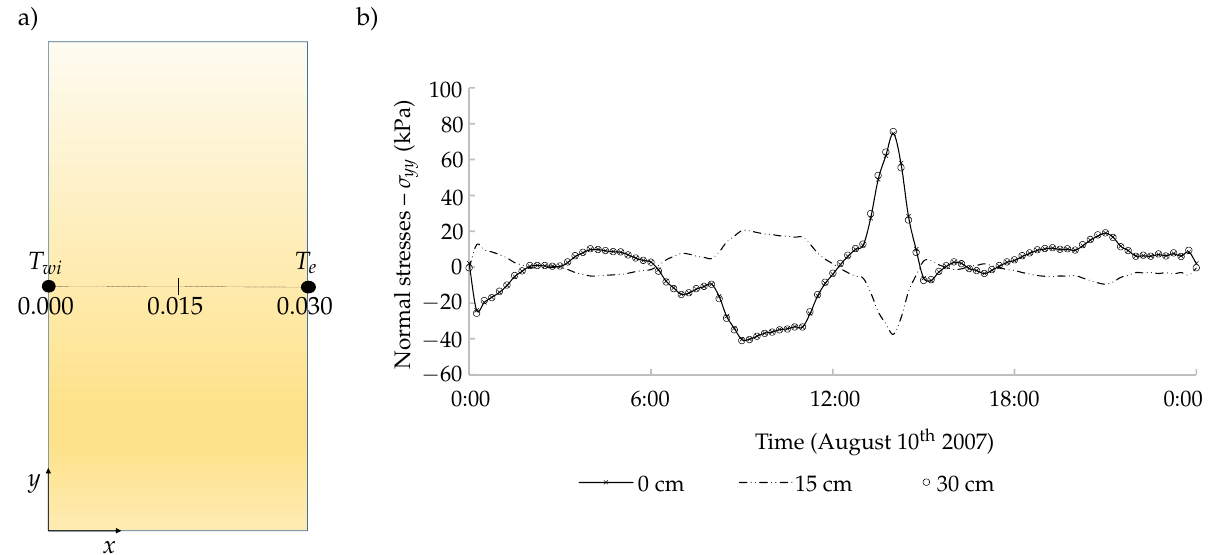
Figure 4. Variation of thermal stresses along the width on 10 August 2007: ( a ) Axis orientation where the 0.000 position represents the internal (hidden) surface and the 0.030 position represents the external (exposed) surface; ( b ) distribution of thermal stress throughout the